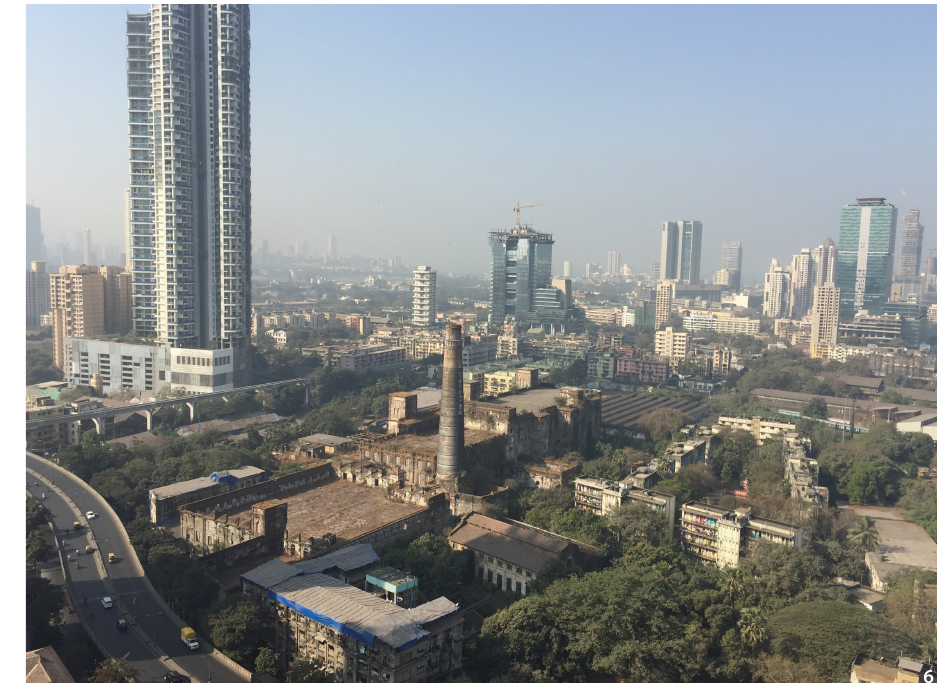
Figure 6 Parel District, Mumbai, 2017. Mill land under transfor- mation to high-end commer- cial and residential properties (Source: the